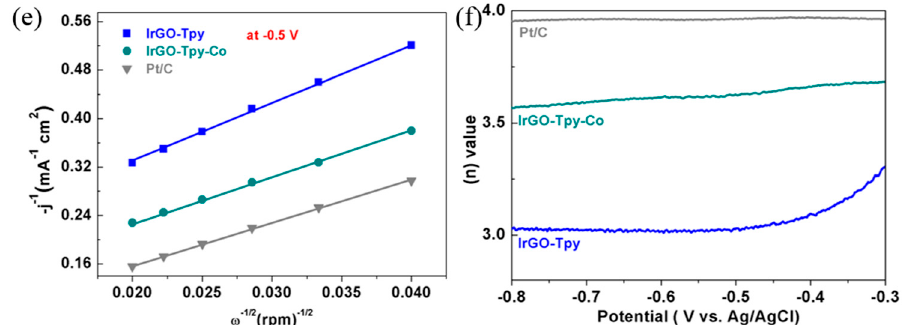
Figure 5. CV curves of ( a ) IrGO-Tpy and ( b ) IrGO-Tpy-Co in O 2 - and N 2 -saturated 0.1 M KOH solution at a scan rate of 10 mV/s, ( c ) RRDE voltammograms of all samples at a rotation speed of 1600 rpm, ( d ) linear sweep voltammetry (LSV) curves of IrGO-Tpy-Co at different rotation speeds (from 625 to 2500 rpm), ( e ) K-L plots of all samples obtained from LSV curves at − 0.5 V, and ( f ) electron transfer number ( n ) of all samples calculated from RRDE voltammograms. Ag/AgCl (saturated KCl filled) was used as a reference electrode for all electrochemical measurements.